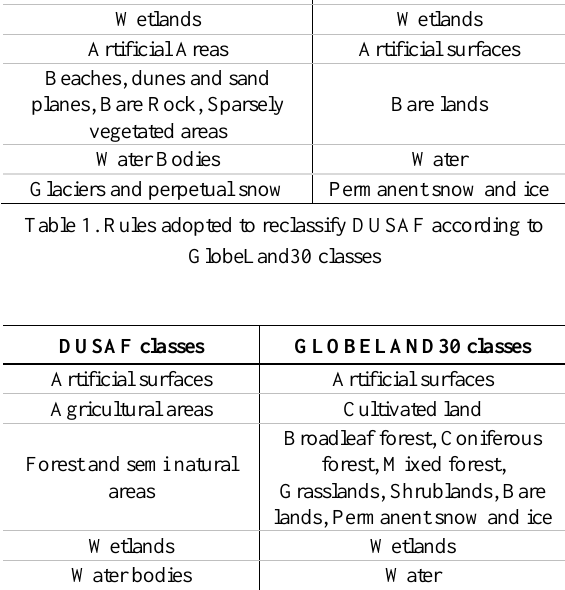
Table 2. Rules adopted to reclassify GlobeLand30 according